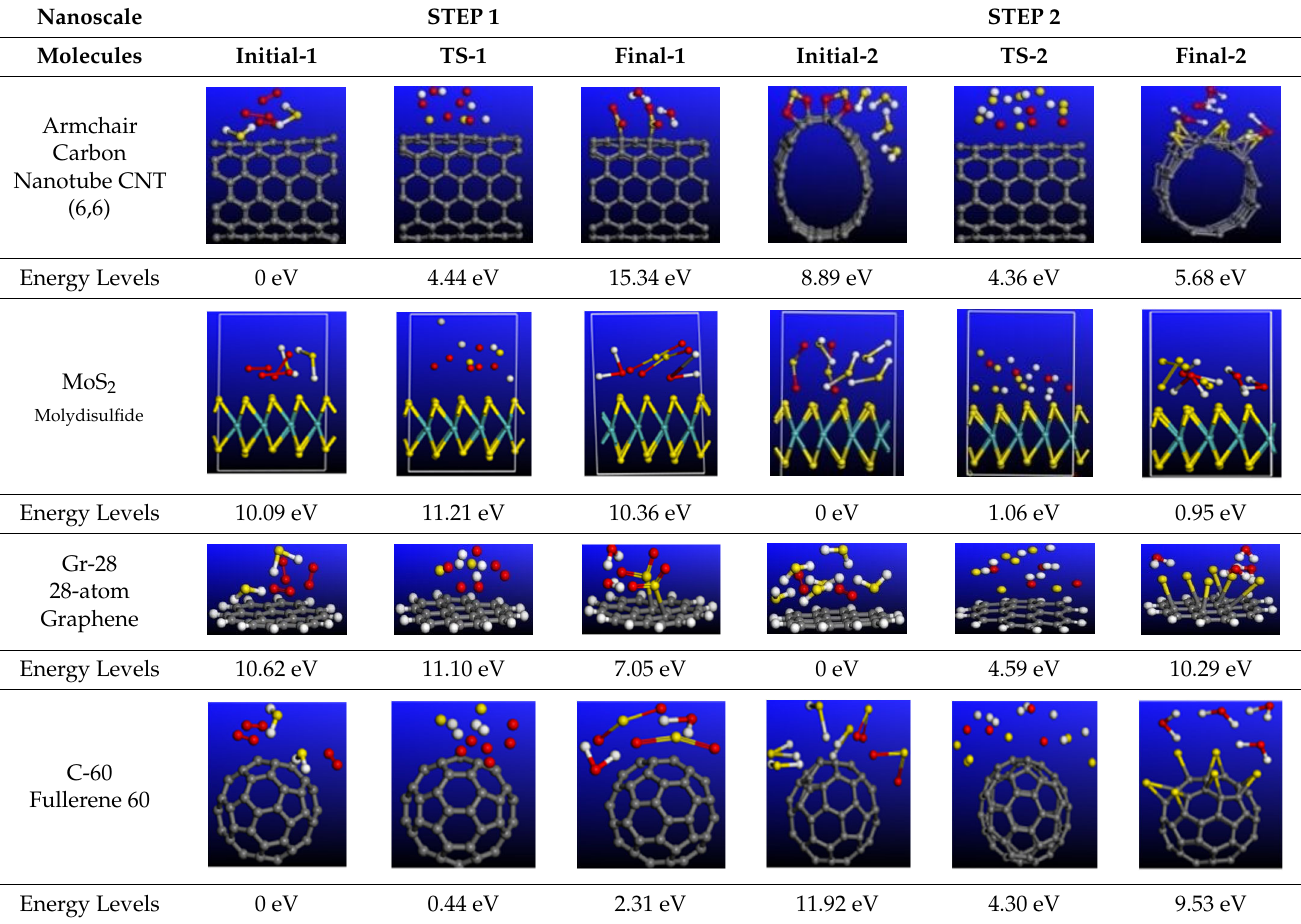
are added to the catalysts in order to further break the bond arrangements of the reactant in step 2 containing Sulfur dihydride and 2 molar Sulfur dioxide. Hence, the oxygen is removed from the sulfur dioxide due to bond breakage to form 3 molar diatomic sulfurs and 4 molar water in the final product of step 2. The addition of doubly ‐ charged negative ions to the spherical, cylindrical, and planar nanoscale catalysts functions as a “chemical tuning” agent for each step of the dehydro ‐ sulfurization reaction [18–22]. Moreover, the varying of the catalysts with each step of the redox reaction mimics the biocatalytic mech ‐ anism of sucrose conversion to organic honey through the flow of 2e ‐ electrons that simi ‐ larly cause bond breakage and bond reformation occurring in the reaction barriers. The relative barriers generated by the 2e ‐ electrons addition are compared with reference to the initial states according to Equation (3). The two ‐ step chemical reaction can therefore be tailored with various levels of control at each step of the reaction by the sequential application of homogeneous and/or heterogeneous catalysts, as indicated by Figures 1–7. The percentage barrier changes are calculated with Equation (5) and are presented in Ta ‐ ble 1, showing that the reaction barriers are increased in Figure 3 by 92.6% and 73.2% for